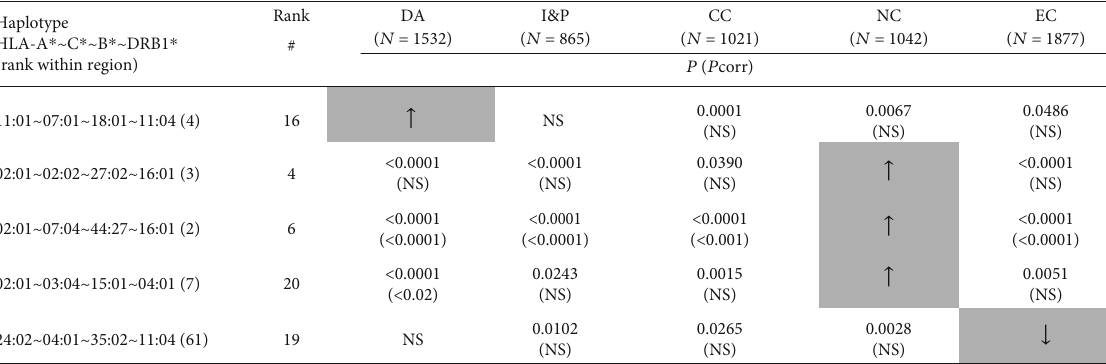
Figure 4: The list of HLA-A ~ C ~ B ~ DRB1 haplotypes among 20 most frequent in the general Croatian population, which demonstrated a signi fi cantly di ff erent frequency in one region in comparison to the at least three other regions. Legend: # Zagreb/general Croatian population; DA: Dalmatia; I&P: Istria & Primorje; CC: Central Croatia; EC: East Croatia; NC: North Croatia; ↑ / ↓ : frequency signi fi cantly higher/lower than in at least three other regions; grey-shaded box: region di ff ering in haplotype frequency from at least three other regions; P : value for comparison of speci fi c region di ff ering in haplotype frequency from at least three other regions; P corr: P value corrected for multiple testing; NS: not signi fi